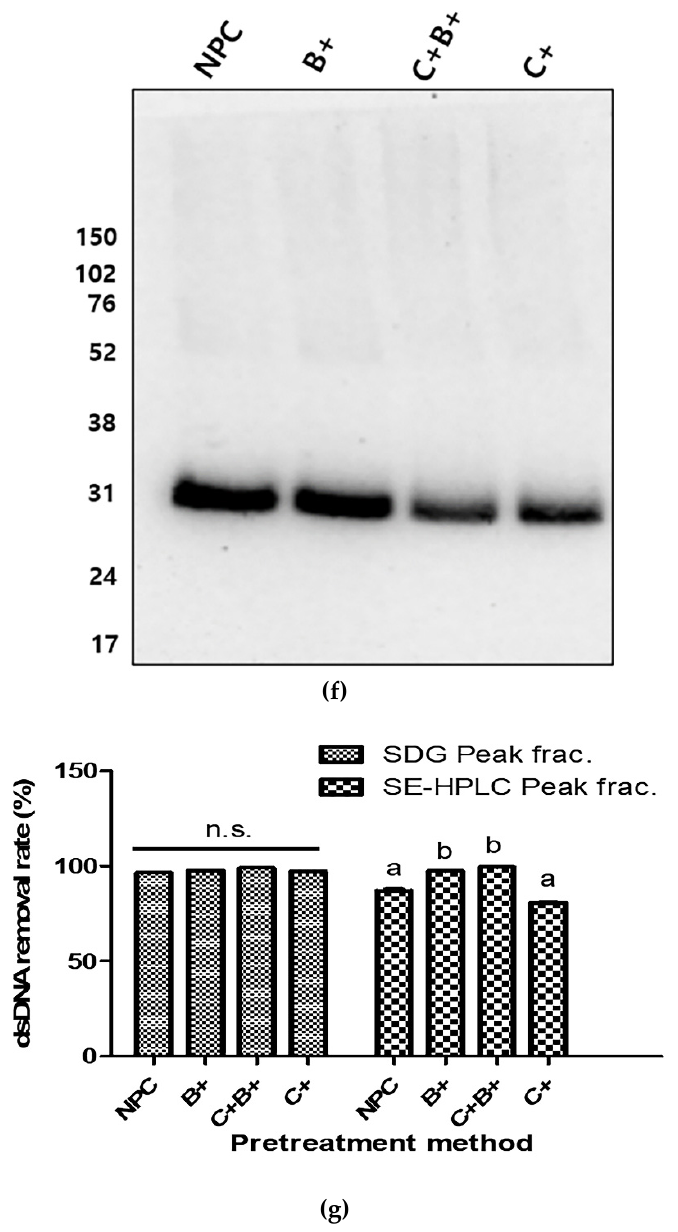
Figure 2. Purity of 146S antigen peak fractions collected by SE-HPLC from the 10 × concentrates for PEG precipitate (PEG-P) of FMDV O SKR/Boeun/2017: ( a ) original chromatograms from SE-HPLC of PEG-P (10 × ) without pretreatment (NPC); ( b ) Original chromatogram from SE-HPLC of PEG-P (10 × ) with benzonase digestion (B+); ( c ) original chromatogram from SE-HPLC of PEG-P (10 × ) with combinational pretreatment of chloroform and benzonase (C+B+); ( d ) original chromatogram from SE-HPLC of PEG-P (10 × ) with chloroform extraction (C+). Yellow backgrounds indicate the collected target peak fractions; ( e ) a silver-stained gel after SDS-PAGE of SE-HPLC target peak fraction dependent on each pretreatment method; ( f ) Western blot result against FMDV type O VP1 on SE-HPLC target peak fraction dependent on each pretreatment method; ( g ) dsDNA removal rate (%) of each target peak fraction of PEG-P (10 × ) pretreated with various methods. Groups that do not share a letter are significantly different ( p < 0.05). Abbreviations: SE-HPLC, size-exclusion high-performance liquid chromatography; M, marker